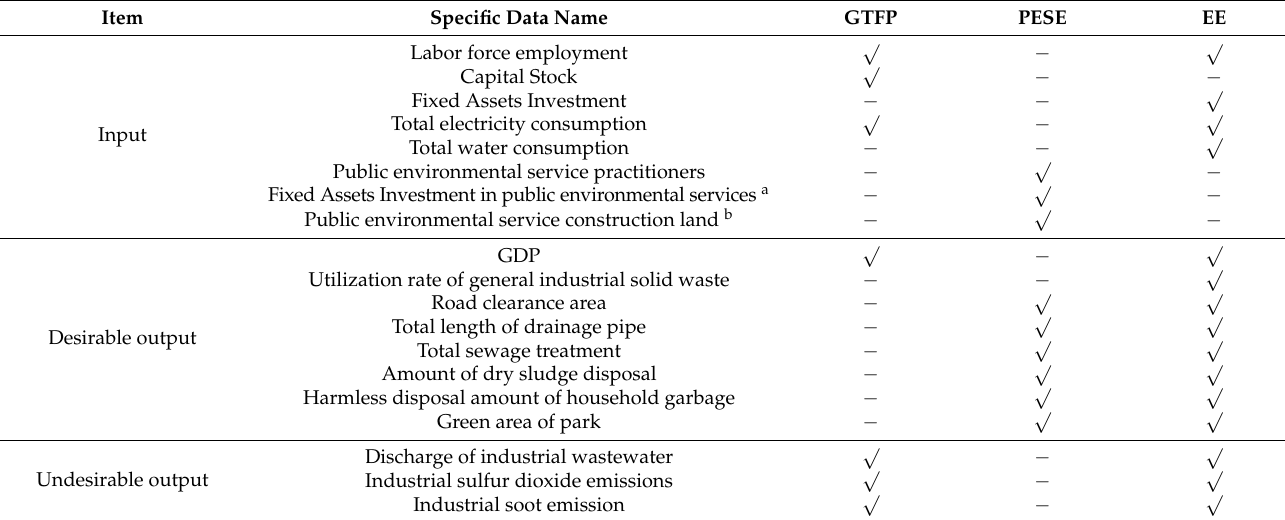
Table 1. Inputs and outputs on the evaluation of EE, GTFP, and PESE